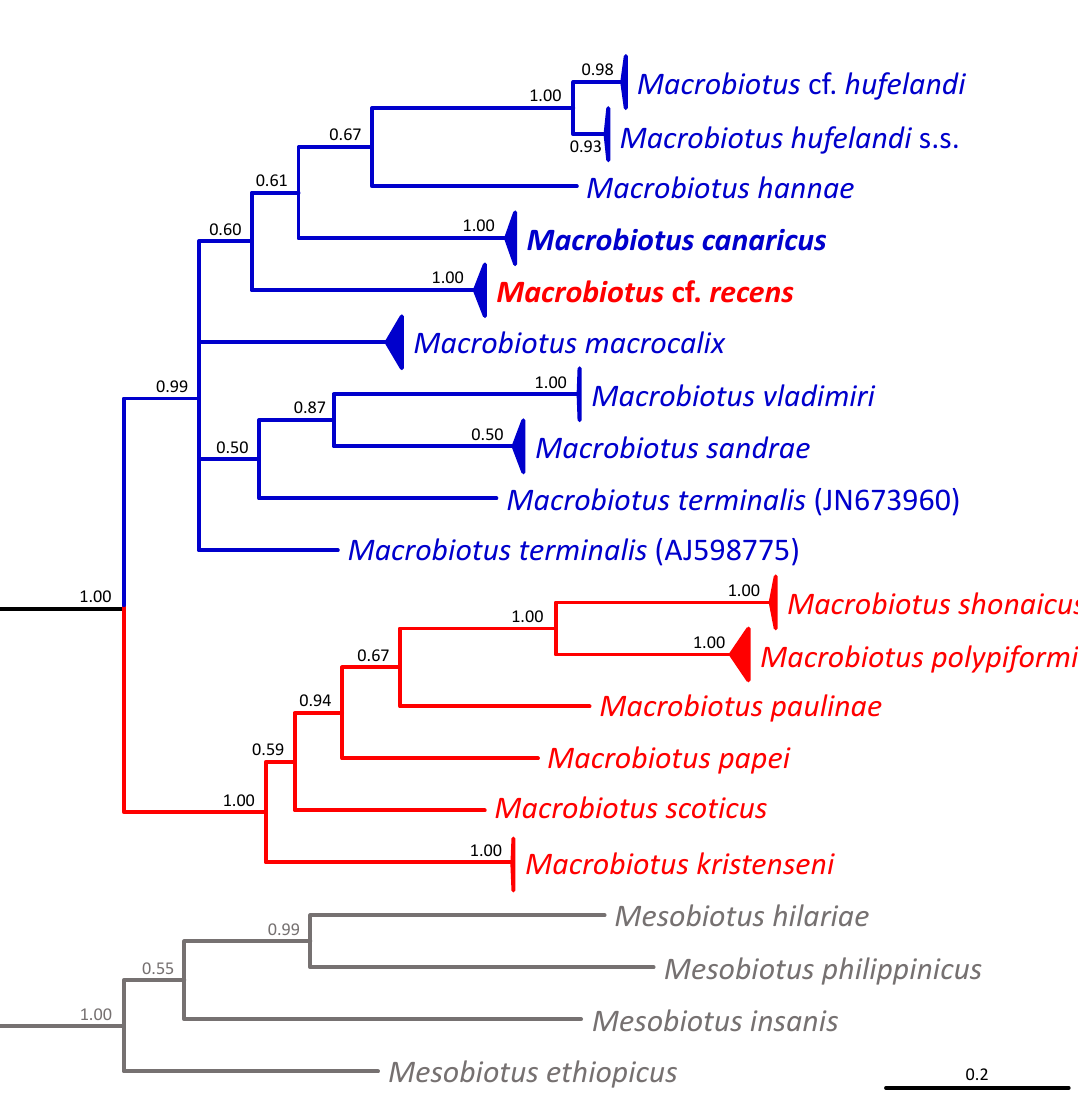
Fig. 17. The Bayesian Inference (BI) phylogeny constructed from COI sequences of the species of the Macrobiotus hufelandi group. Numbers at nodes indicate the Bayesian posterior probability. Species of the hufelandi group with typical and atypical egg processes are indicated by blue and red fonts, respectively. See Table 2 for details on the species sequences used in the analysis. The outgroup is marked with grey. The scale bar represents substitutions per